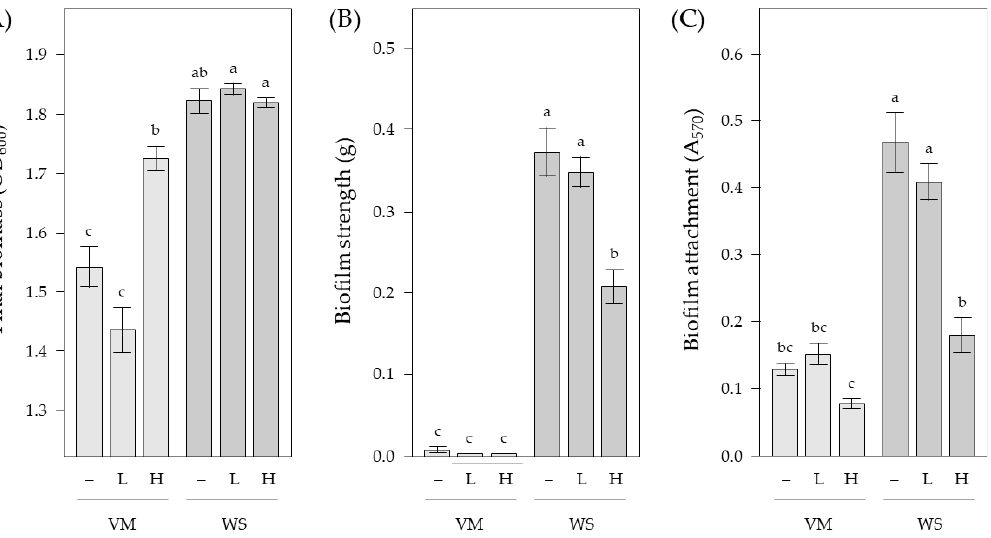
Figure 4. Exogenous DNA affects P. fluorescens SBW25 biofilm development. Low-molecular-weight (LMW) and high-molecular-weight (HMW) DNA was added to microcosms and Viscous Mass (VM) and Wrinkly Spreader (WS) biofilms allowed to develop for three days before assay. Shown here are the final microcosm biomass (OD 600 ) ( A ), biofilm strength (grams) ( B ), and attachment (A 570 ) ( C ) measurements ( – , no exogenous DNA added; L, LMW DNA added; H, HMW DNA added). Means ( n = 8 – 24) ± SE are shown. Differences between means were determined for each set of measurements by one-way ANOVA and post hoc Tukey–Kramer HSD tests. Means sharing the same letter are not significantly different ( α = 0.05).